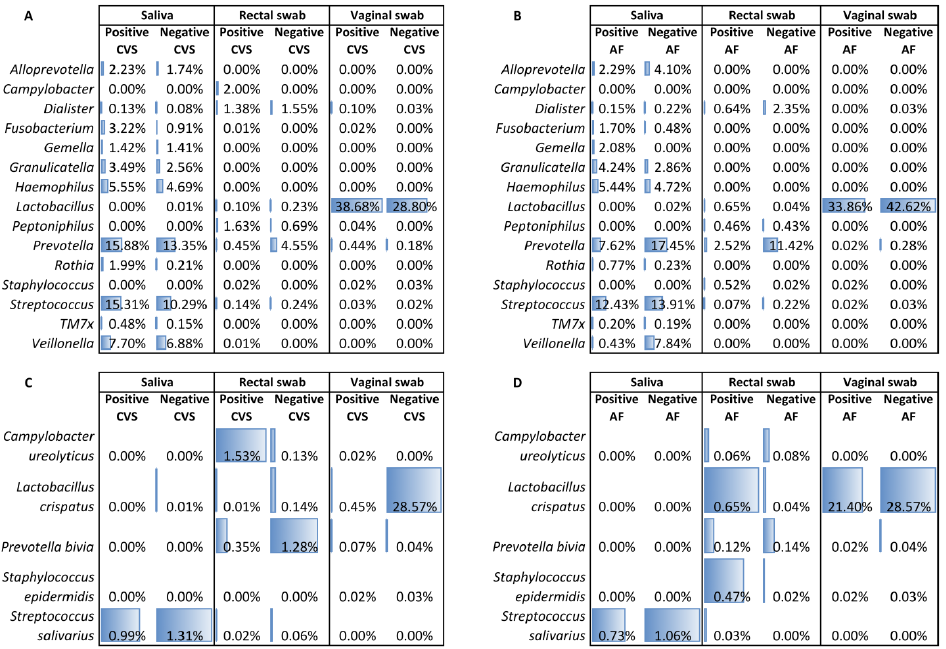
Figure 4. ( A , B ) Significantly different bacterial genera among samples matched to positive and negative CVS and AF samples. ( C , D ) Significantly different bacterial species among samples matched to positive and negative CVS and AF samples. Biomarkers identified by the LEfSe test. Data are shown as median relative abundances. The same analysis was performed at the species level (Table S4). Figure 4C shows the increase in S. salivarius in the saliva samples and of L. crispatus in the vaginal samples matched to the negative CVS when compared to the samples matched to the positive CVS. C. ureolyticus increased in the rectal samples matched to the